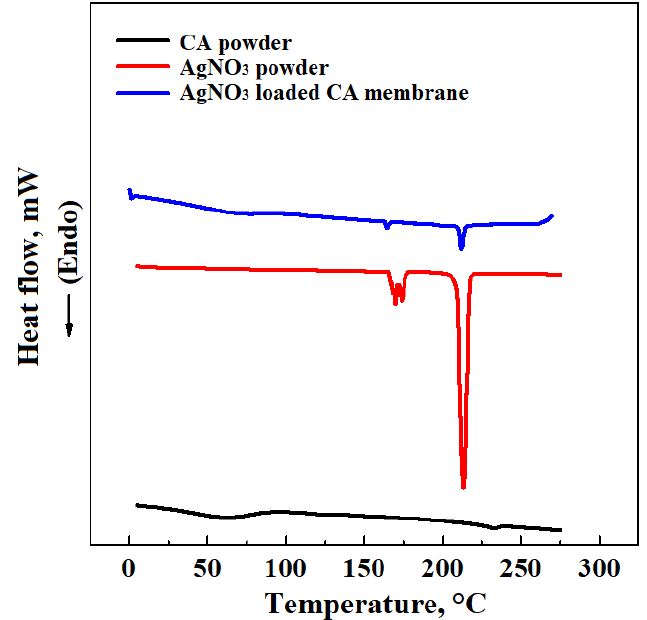
Figure 3. Comparison among AgNO 3 , CA and AgNO 3 /CA composite membranes thermograms.